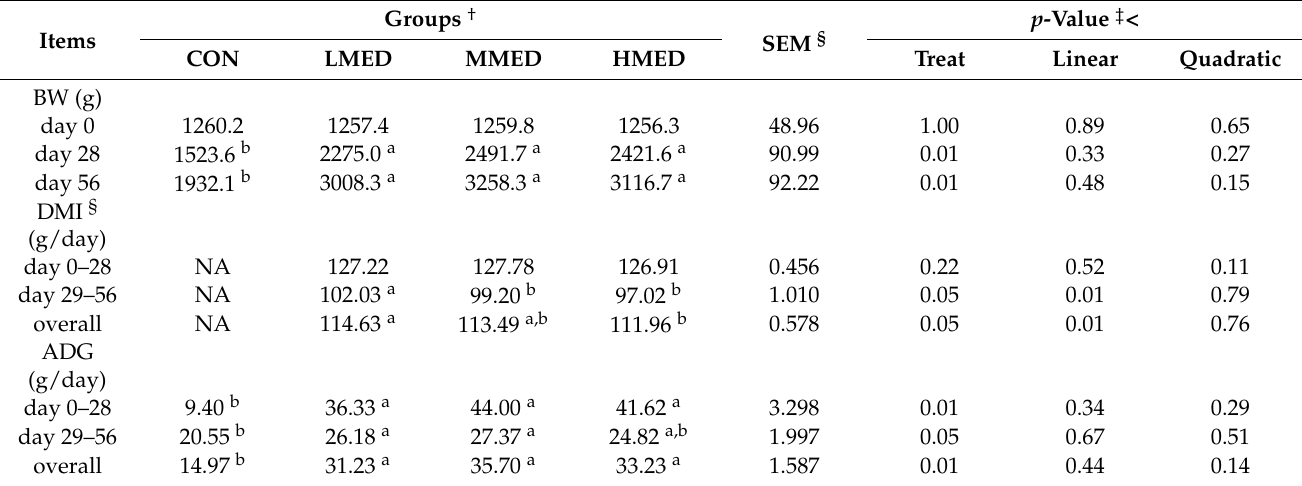
Table 2. Effects of supplemental feeding diets with three levels of metabolizable energy (ME) on growth performance of grazing Swan geese.